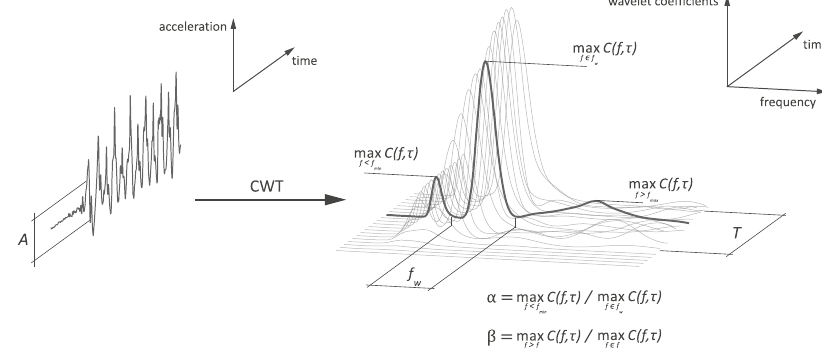
Fig. 2 Visualization of signal features. Vector magnitudes of raw time-domain accelerometer signal is used to compute peak-to-peak amplitudes in one-second segments, which are then compared to a prede fi ned threshold A; segments with amplitude below the threshold are excluded from further processing. Time-frequency decomposition computed using CWT reveals temporal gait features (wavelet coef fi cients) within, below, and above typical step frequency range f w , used to calculate gait harmonics parameters α and β . The activity is classi fi ed as walking when all amplitude- and frequency-based conditions are satis fi ed for at least T segments